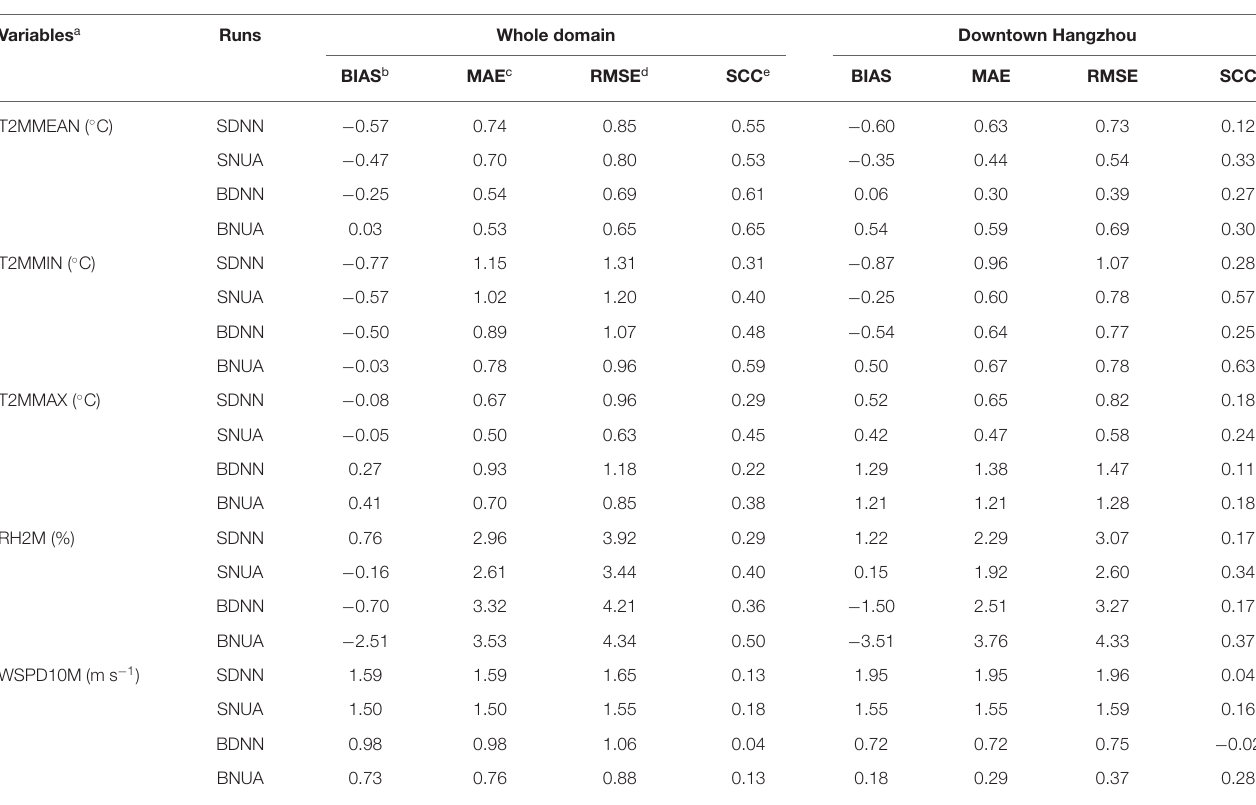
TABLE 3 | Evaluation of temperature at 2m, relative humidity at 2m, and wind speed at 10m over the whole domain and the downtown Hangzhou. Variables